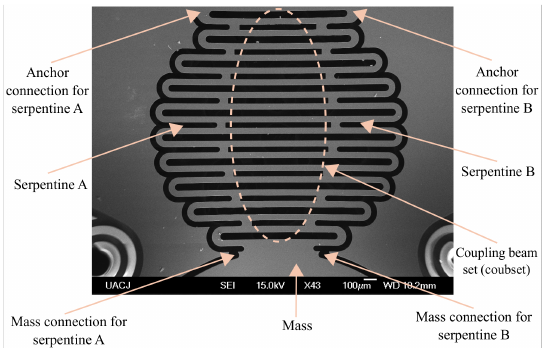
Figure 3. SEM image of one supporting spring of the proof